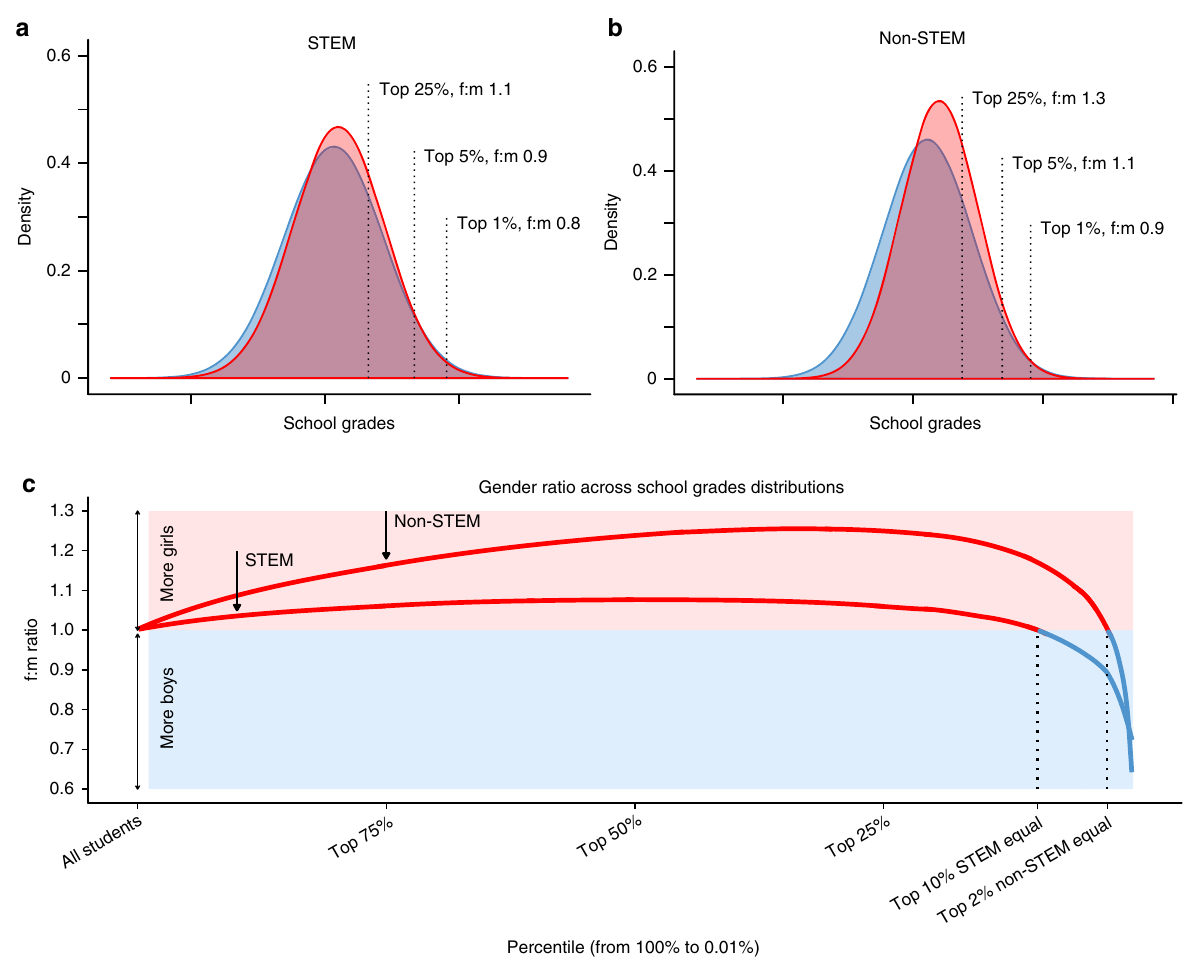
Fig. 3 Inferred relative distributions of academic abilities of girls (red) and boys (blue). a STEM and b non-STEM school subjects, c the proportion of girls in each percentile. The relative mean and variance for each gender are based on the results of the meta-regression of school grades for school pupils, with subject as a moderator. In a and b , dashed vertical lines indicate cutoff points, above which 25%, 5% and 1% of top-scoring pupils can be found. The proportion of girls to boys across the distribution is shown in c , where values to the right on the x -axis correspond to the right tail of the achievement distributions. f:m values represent ratios of top-scoring girls to boys above each cutoff point (i.e, f:m > 1 = more females; f:m < 1 = more males). Data and code for reproducing this fi gure are available at refs.